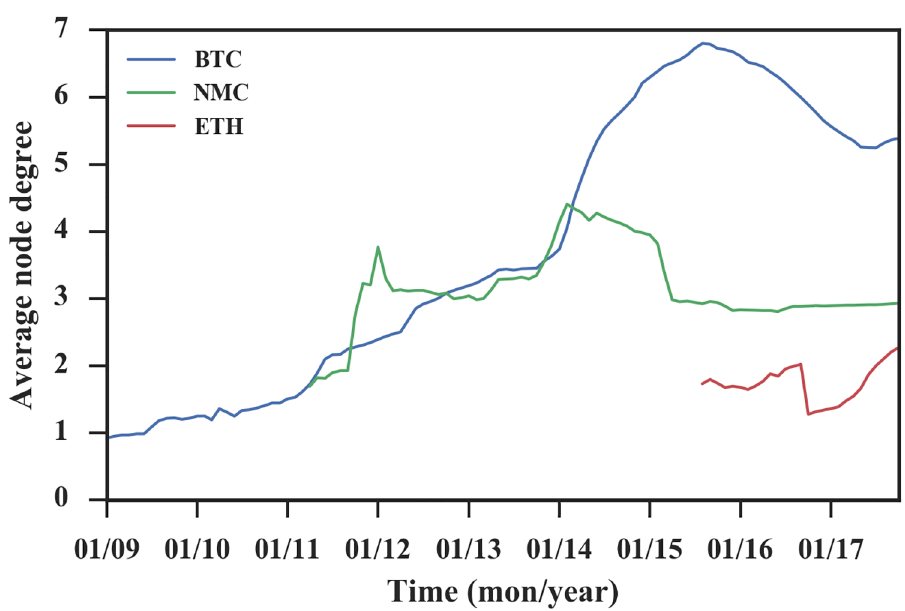
Fig 3. The average node degree of accumulated networks over time. The average degree of the three networks is not constant.